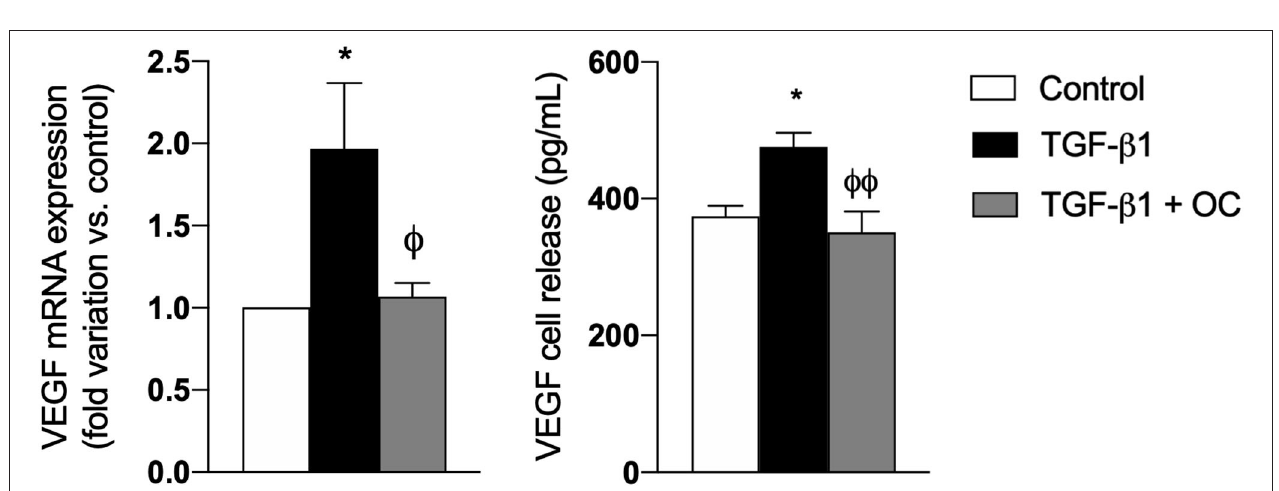
FIGURE 3 | Effect of OC on MMPs gene expression in LX2 cell line. * P < 0.05, *** P < 0.001 vs. control, φ P < 0.05, φφ P < 0.01 vs. TGF- β 1 treated cells. Results are the mean of 3 independent experiments performed in triplicate and have been analyzed by one-way ANOVA followed by the Tukey’s post hoc test.